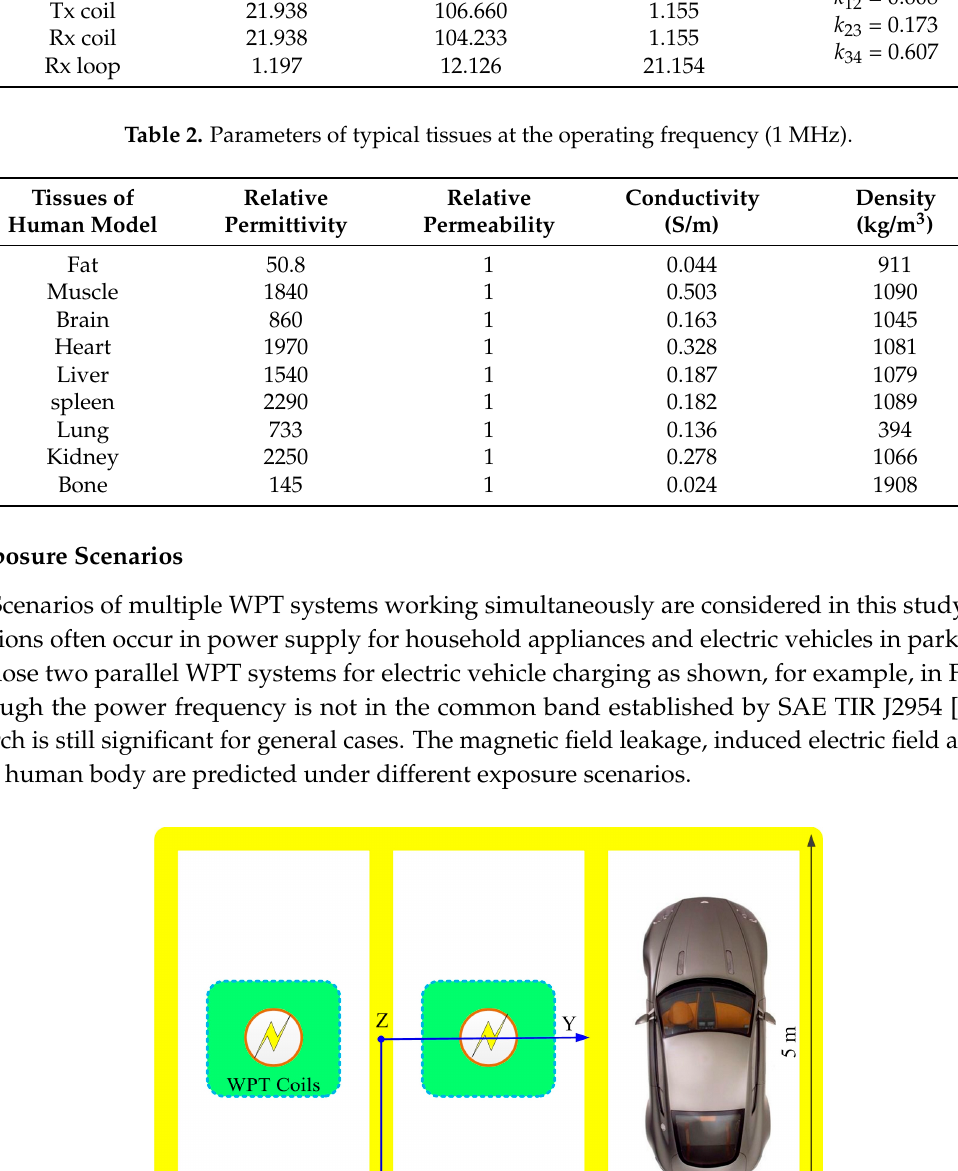
Table 1. Coil parameters without considering the metal effects.